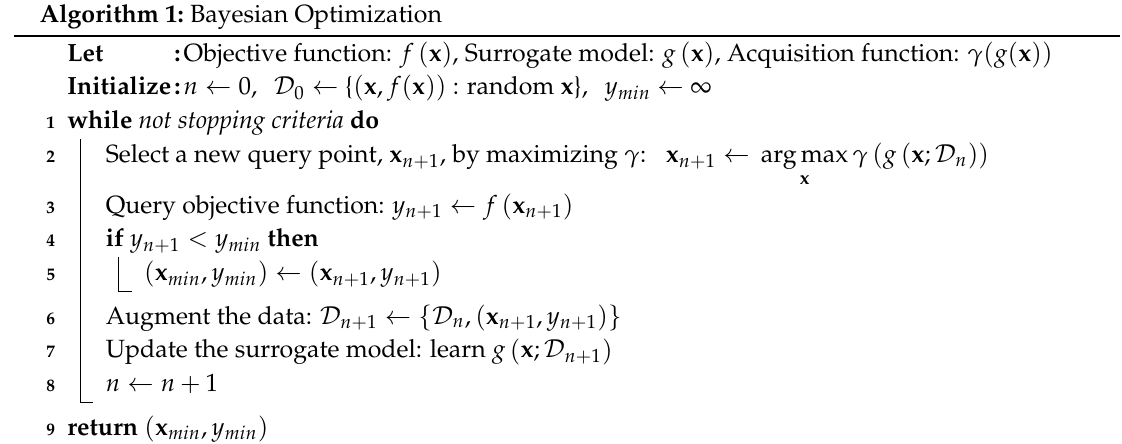
Algorithm 1: Bayesian